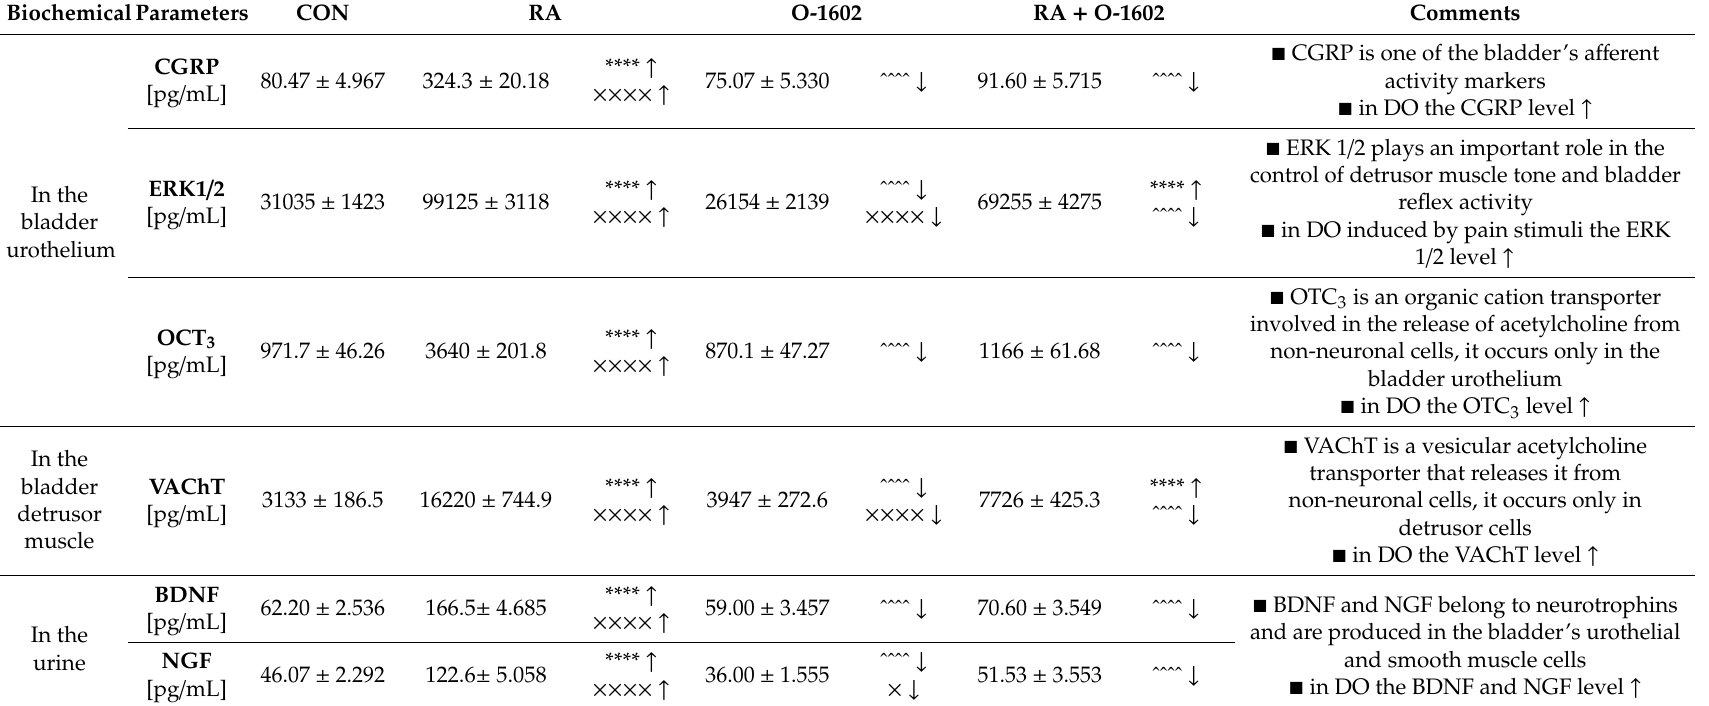
Table 3. Biochemical study